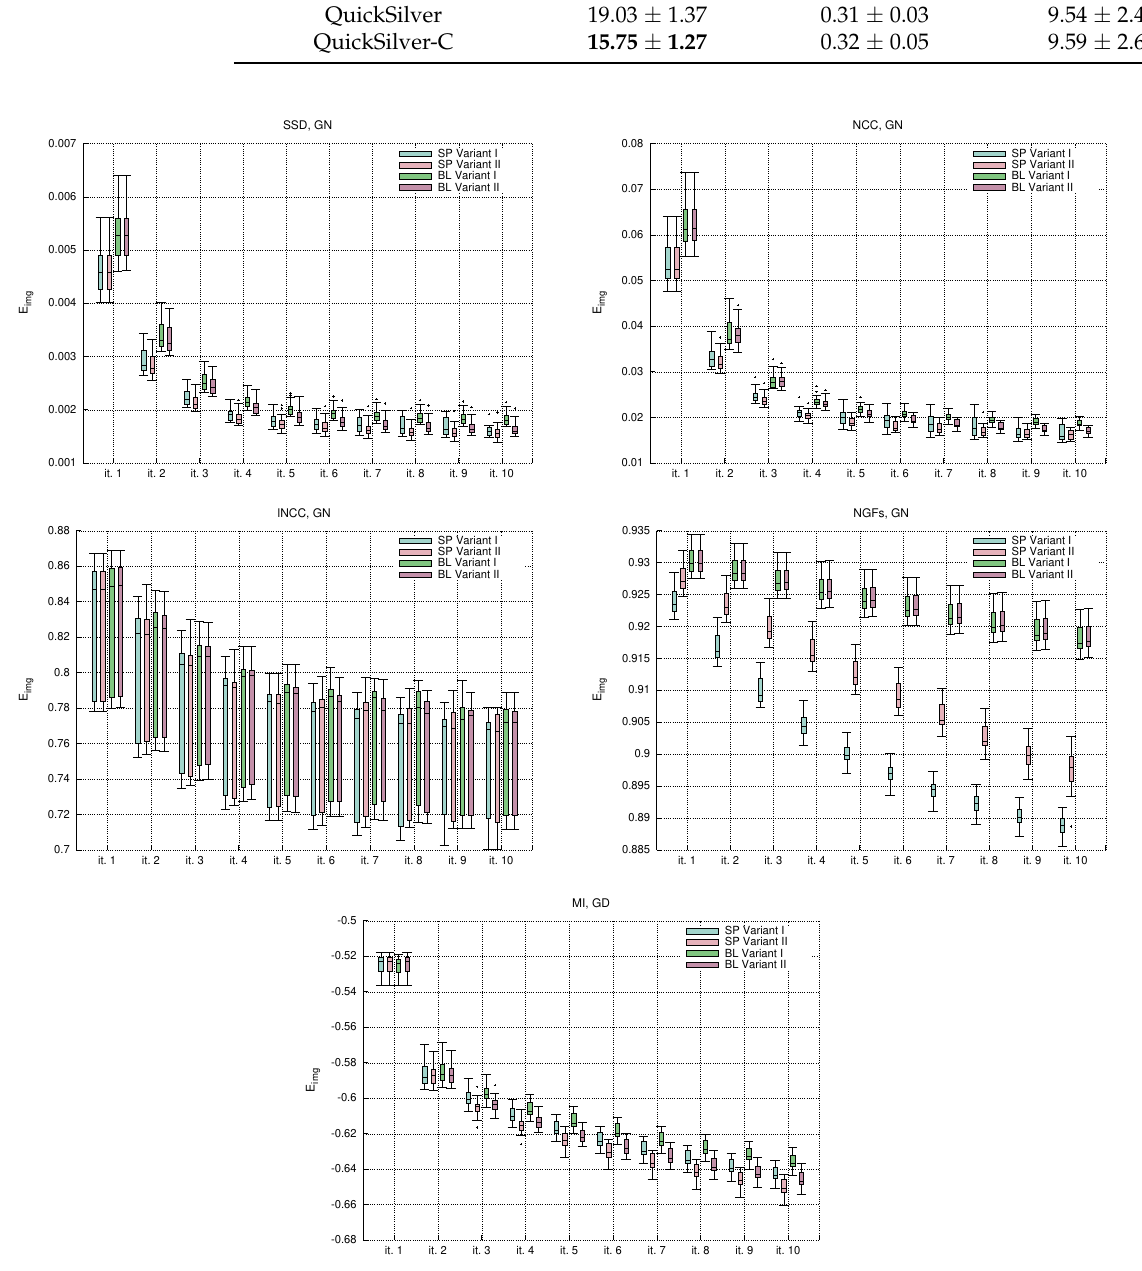
Figure 4. NIREP16. Single-resolution experiments. Box and whisker plots of the E img convergence values in the single resolution experiments. For gradient-descent, the energy values are shown every five 5 iterations.